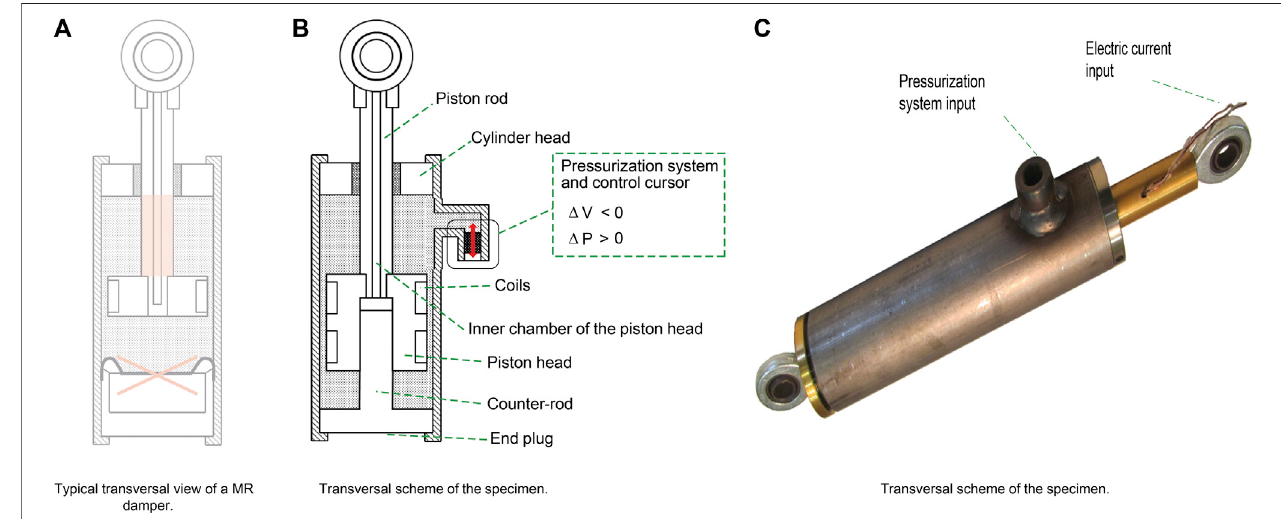
FIGURE 12 | Architecture of the 2DOFMR Damper specimen and assembly.